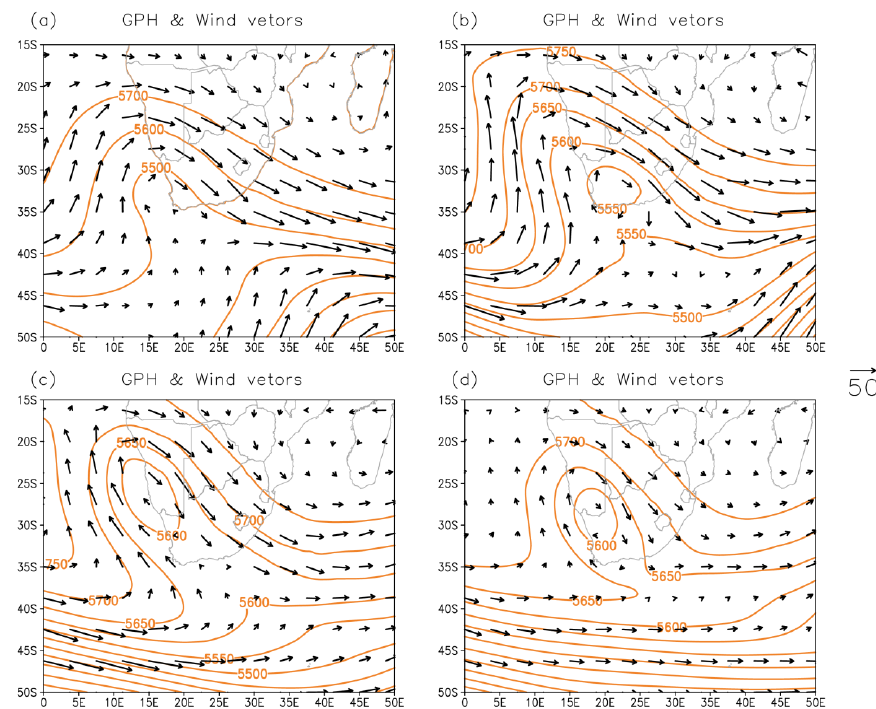
Figure 4. Geopotential height (m) and wind vector (m/s) at 500 hPa during ( a ) 14, ( b ) 15, ( c ) 16, ( d ) 17 August 2002.